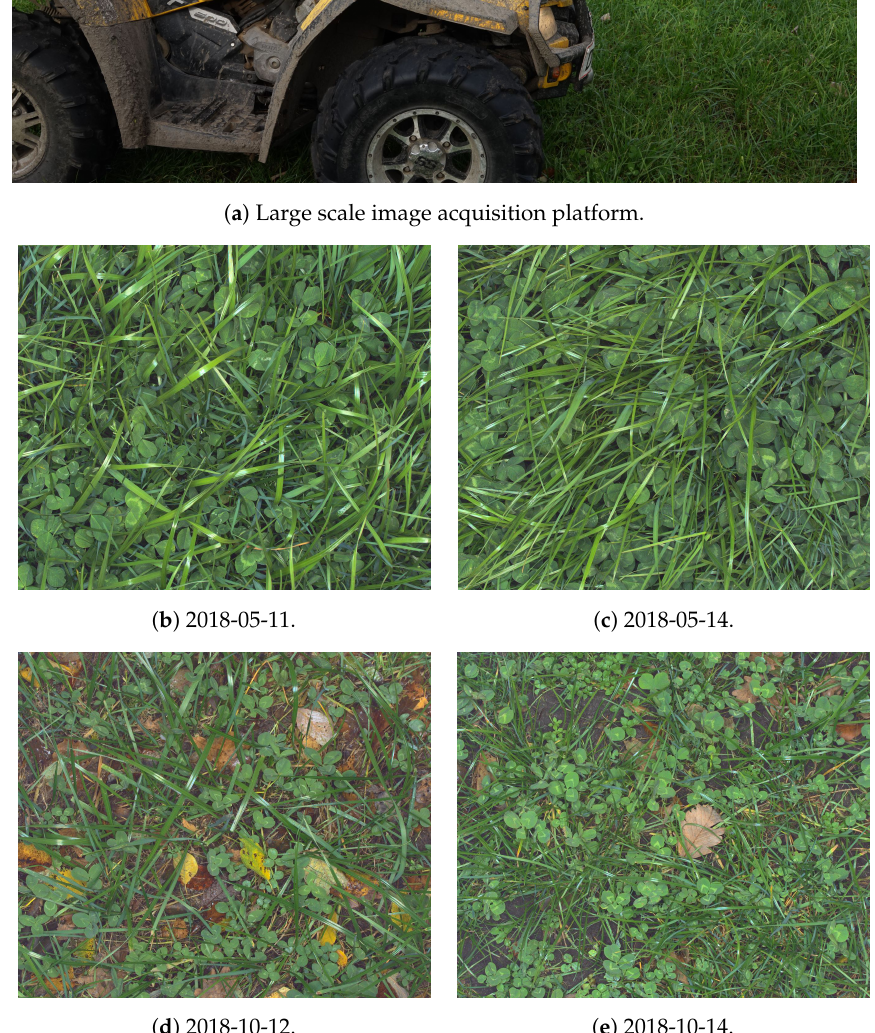
Figure 3. The large scale image acquisition platform and sample images from each day of large scale image acquisition. The difference in yield is noticeable from the larger leaf sizes in the first row, and the visible soil in the bottom row. The images were captured at a velocity of 18kmh − 1 without motion blur due to the specially developed camera